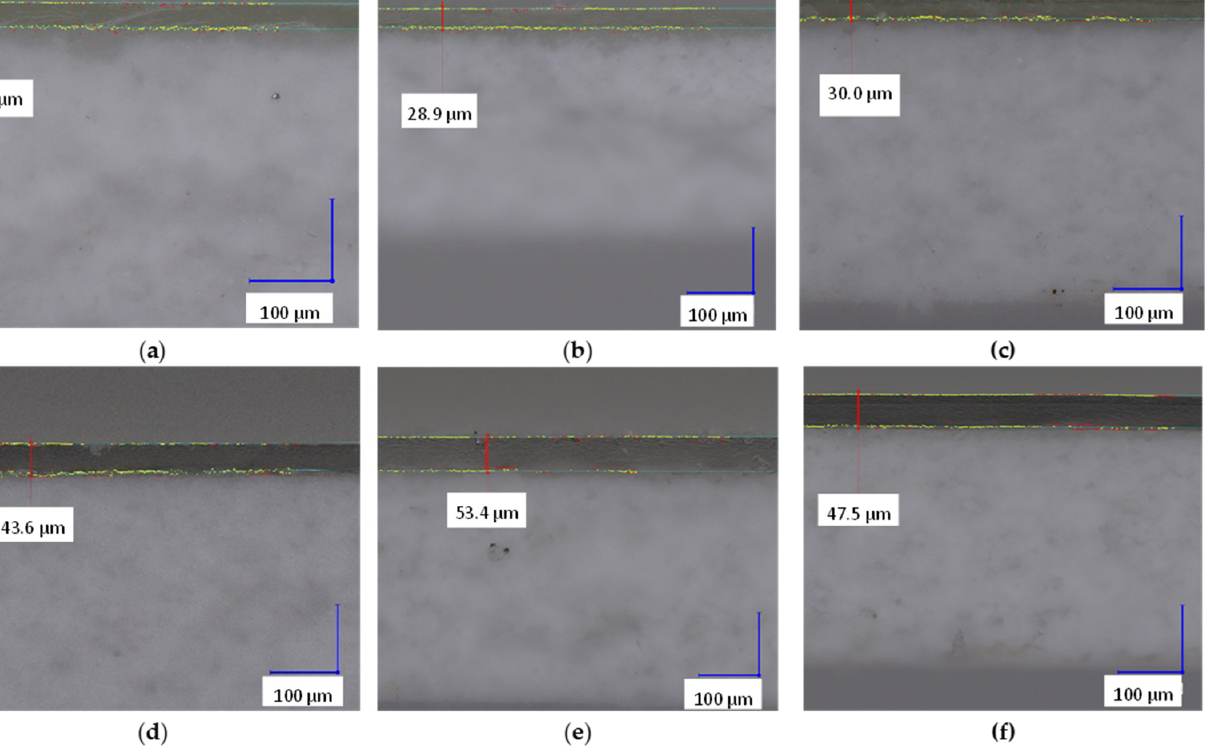
Figure 3. Representative micrographs of the surface for ( a ) UL5, ( b ) UL6, ( c ) UL7, ( d ) EbS-1, ( e ) EbS- 2, and ( f ) EbS-3. The micrographs were not taken for the paper samples but can be considered as representative.